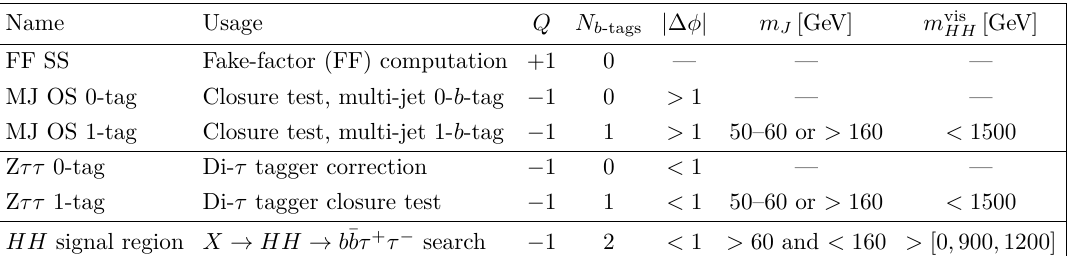
Table 2. Definition of various categories after the event preselection (see text for details), based on the charge product Q of the two leading di- τ sub-jets (OS for opposite-sign, SS for same-sign), the number N b -tags of b -tagged track-jets in the selected large- R jet, the azimuthal angle | ∆ φ | between the di- τ object and the missing transverse momentum, the large- R jet mass m J , and the visible mass m vis of the reconstructed HH HH